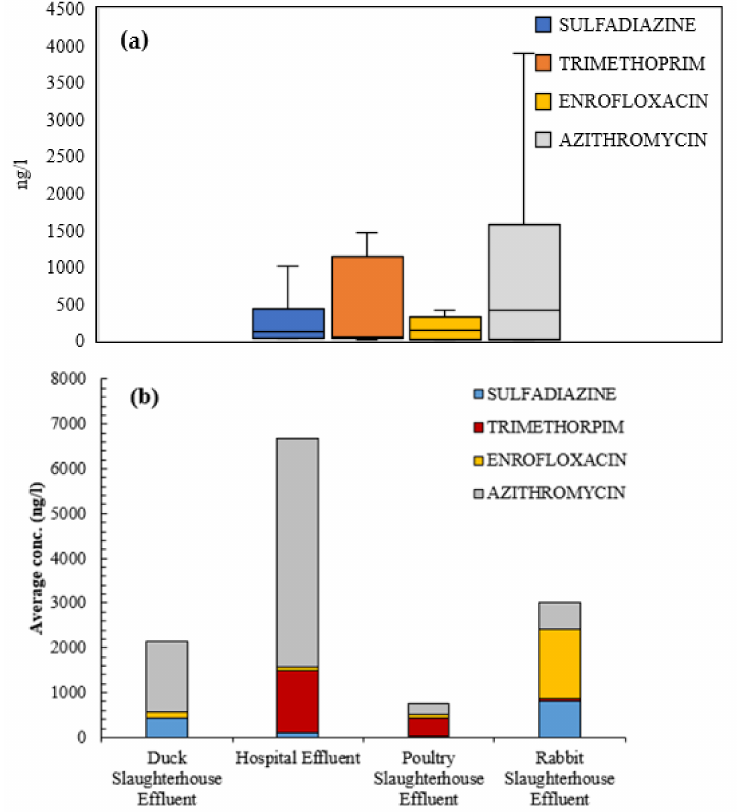
Figure 7. ( a ) Boxplots and ( b ) average concentration (ng/L) of target antibiotics in a hospital and three slaughterhouse